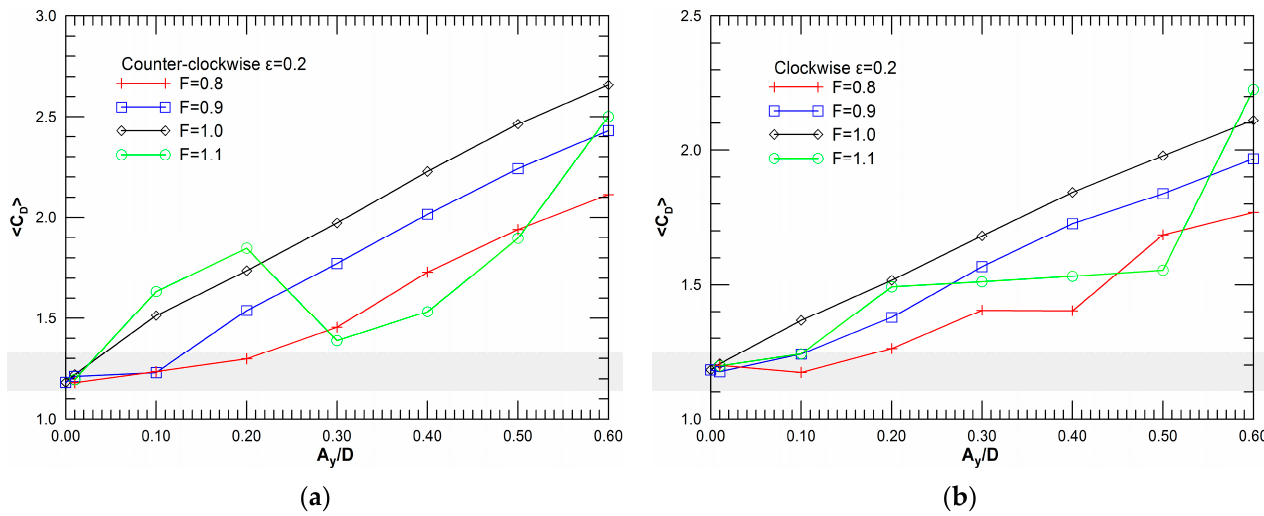
Figure 5. Variation of the mean drag coefficient, <C D >, for ε = 0.2, versus the non-dimensional amplitude A y /D, for frequency ratio F = 0.8, 0.9, 1.0, 1.1: ( a ) counter-clockwise cylinder oscillation, ( b ) clockwise cylinder oscillation.